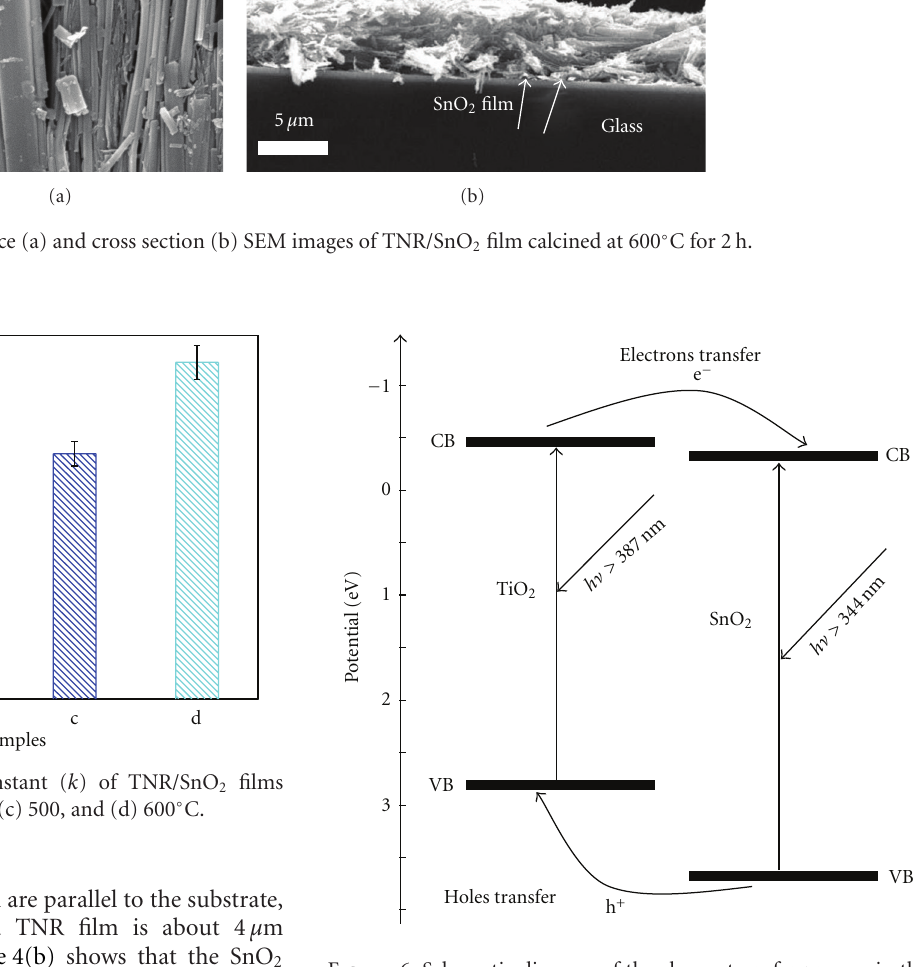
Figure 6: Schematic diagram of the charge-transfer process in the TiO 2 /SnO 2